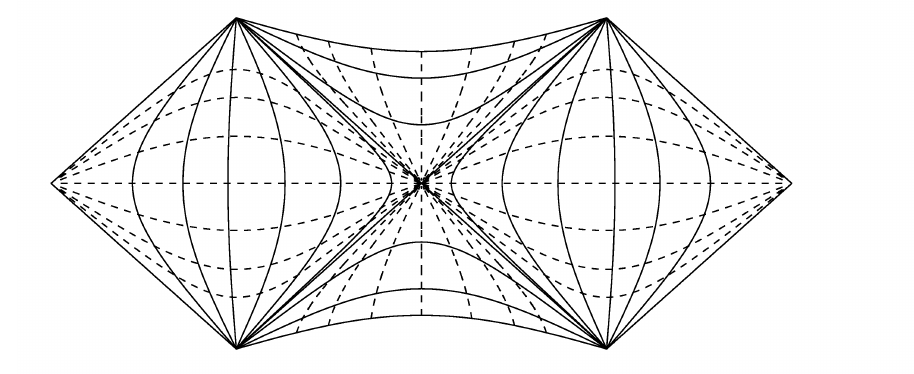
Figure 1 . Constant r lines (solid) and constant t lines (dashed) of the Penrose diagram in the non-rotating